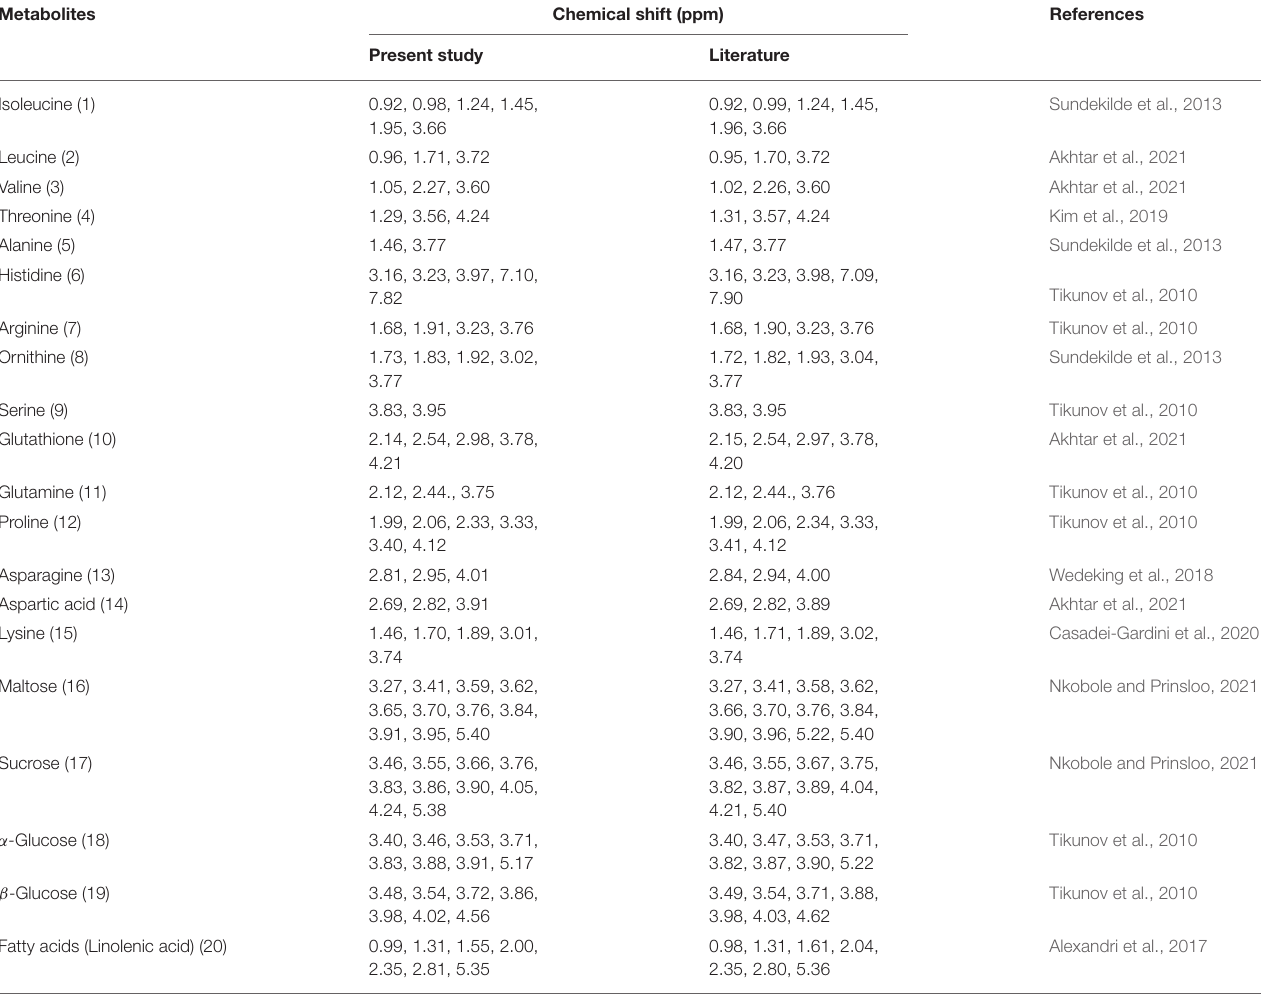
TABLE 1 | Representative of the compounds used for metabolite identification in samples of Fianna and Markies potato as presented in the annotated NMR spectra which caused sample separation between the treatments (i.e., control, flooding and drought).